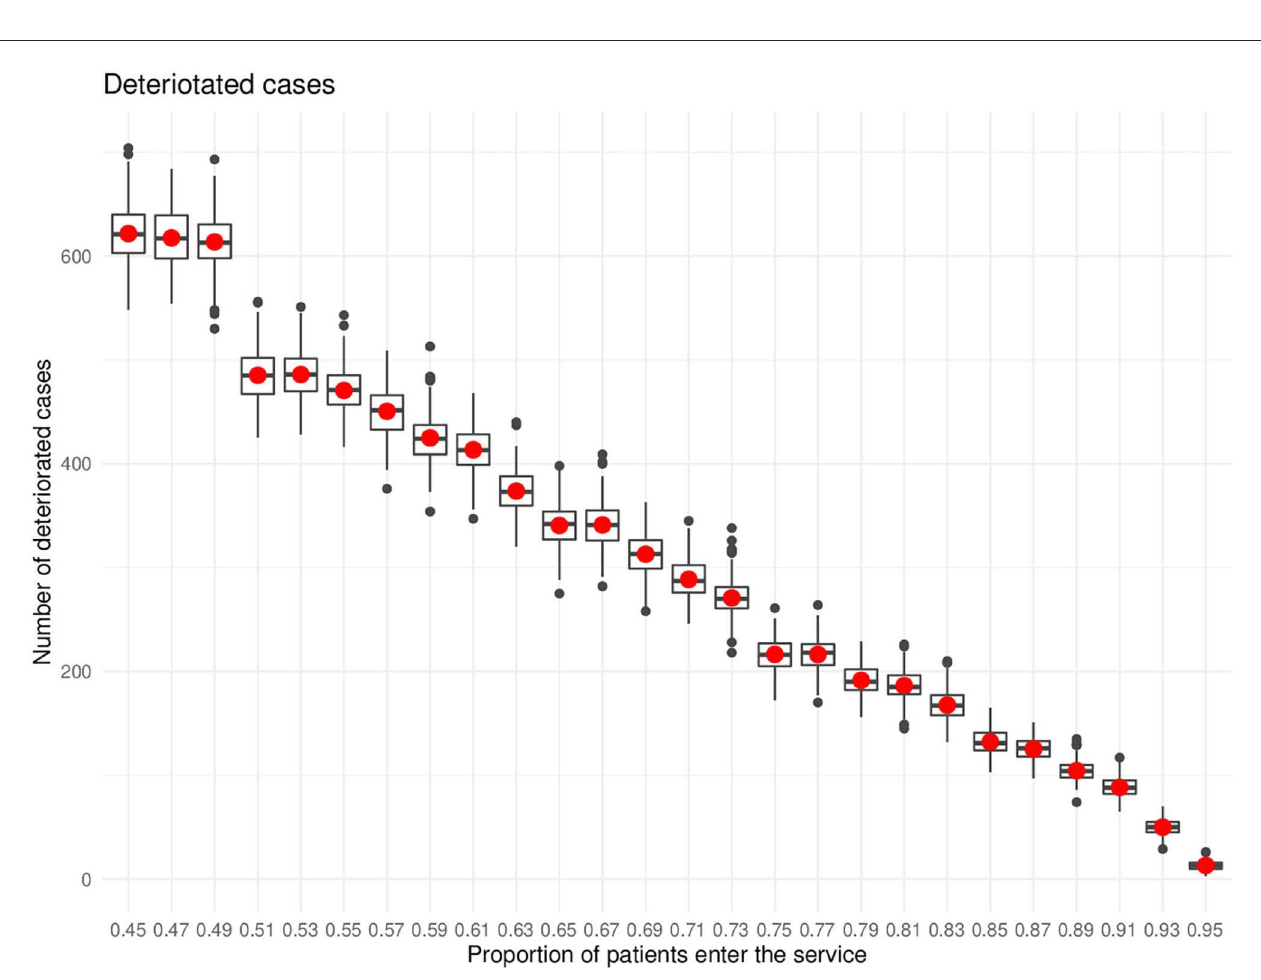
FIGURE4 Deteriorated